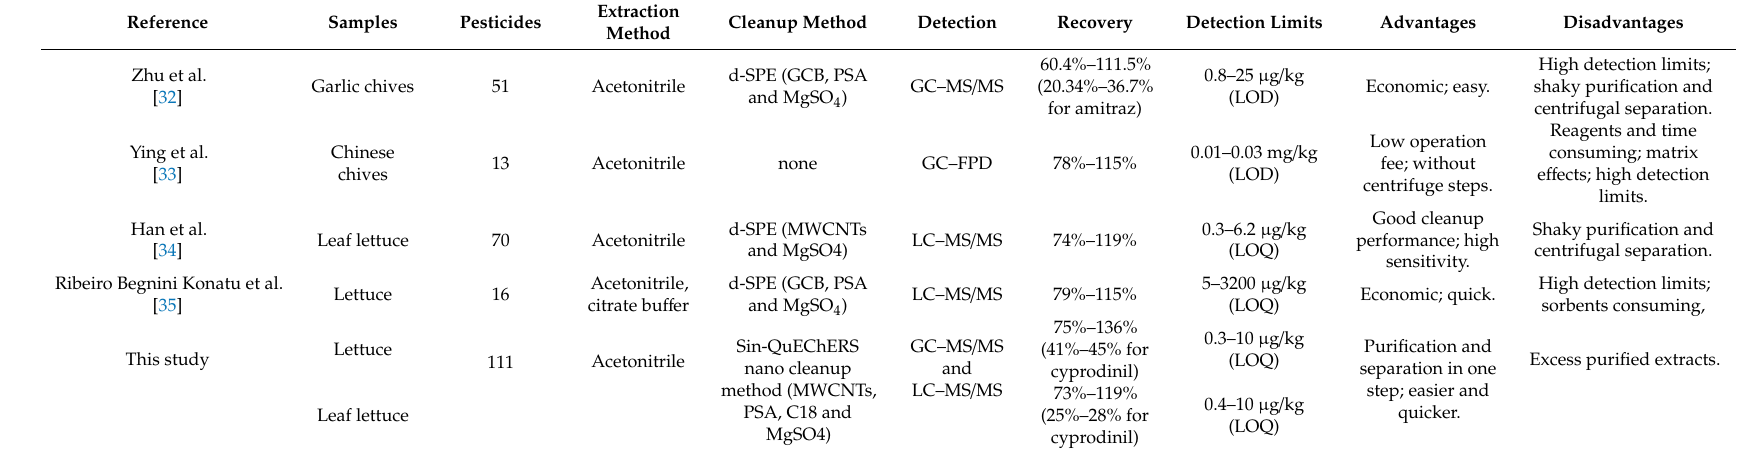
Table 2. Comparison of the quality parameters for determining pesticide residues in lettuce and Chinese chives between the developed method and reported